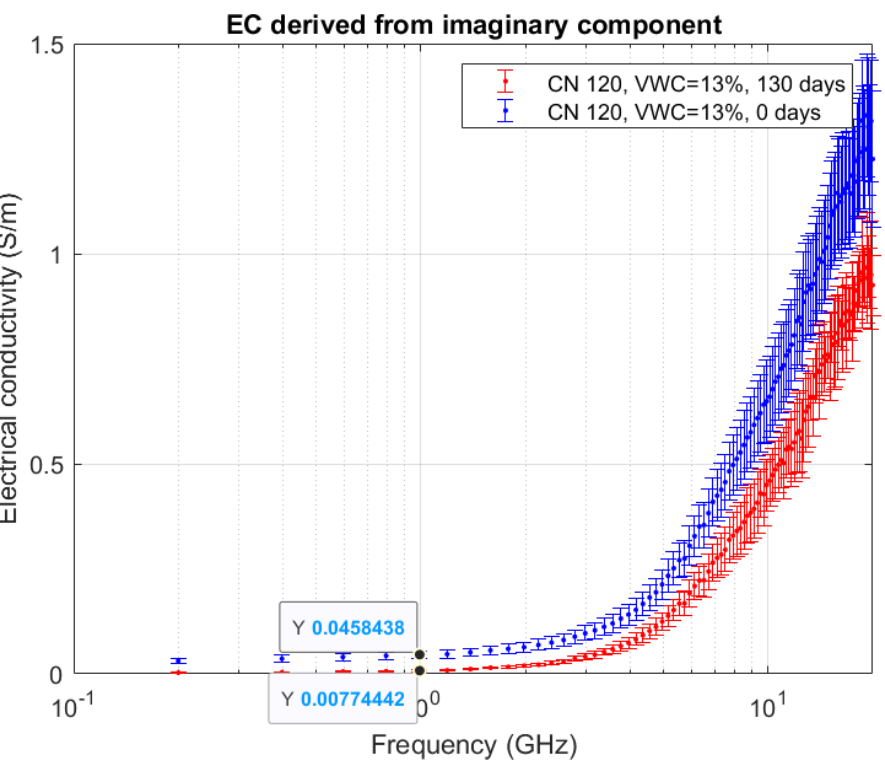
Figure 11. Electrical conductivity derived from the mean of the imaginary component of dielectric permittivity. Microcosm: C/N = 120. Volumetric water content = 13%.